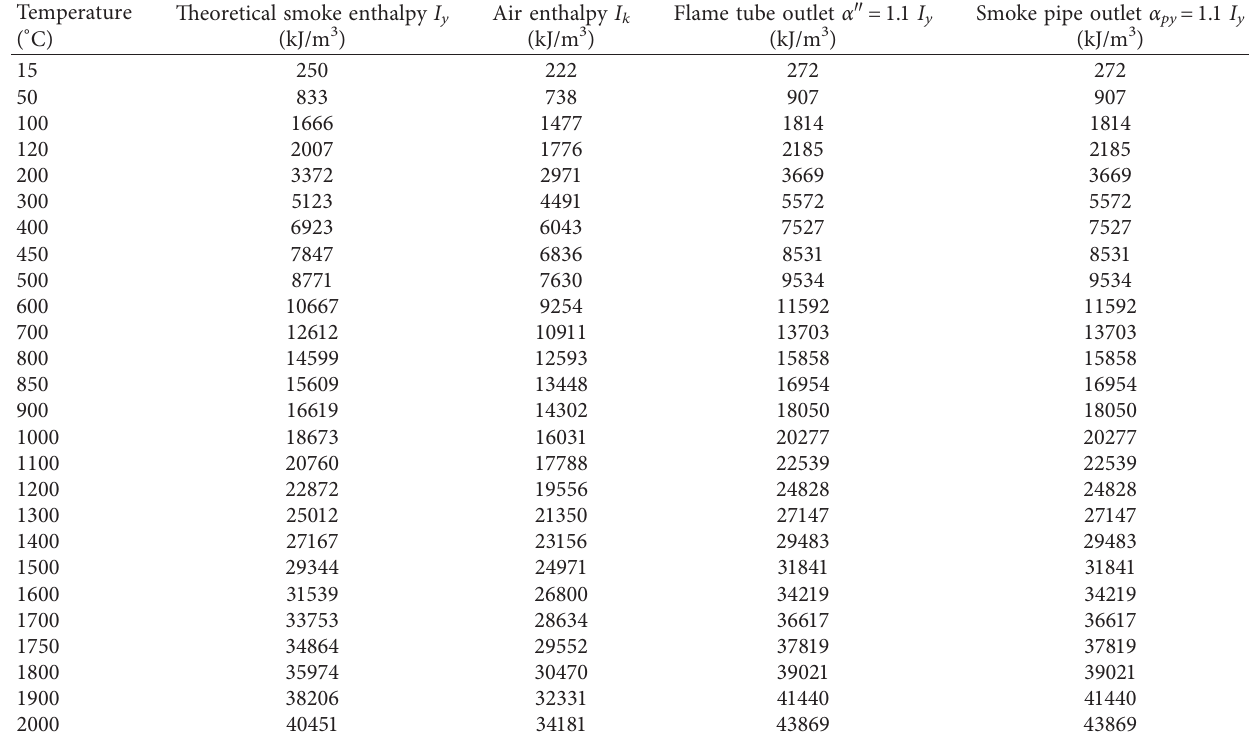
Table 3: Flue gas enthalpy temperature table.